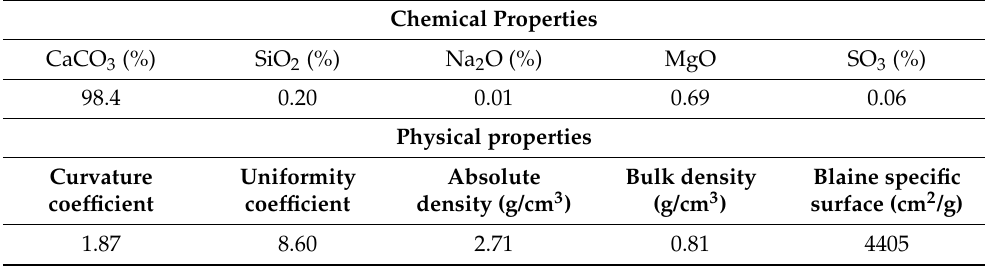
Table 3. Physical and chemical properties of limestone